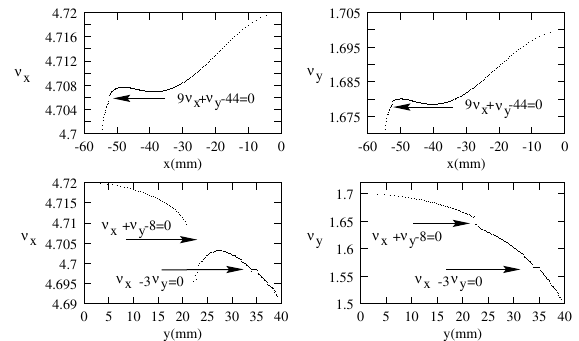
FIG. 13. Super-ACO tune shifts with amplitude. For each case the fixed coordinate x or y is set to 1 (cid:1) m .